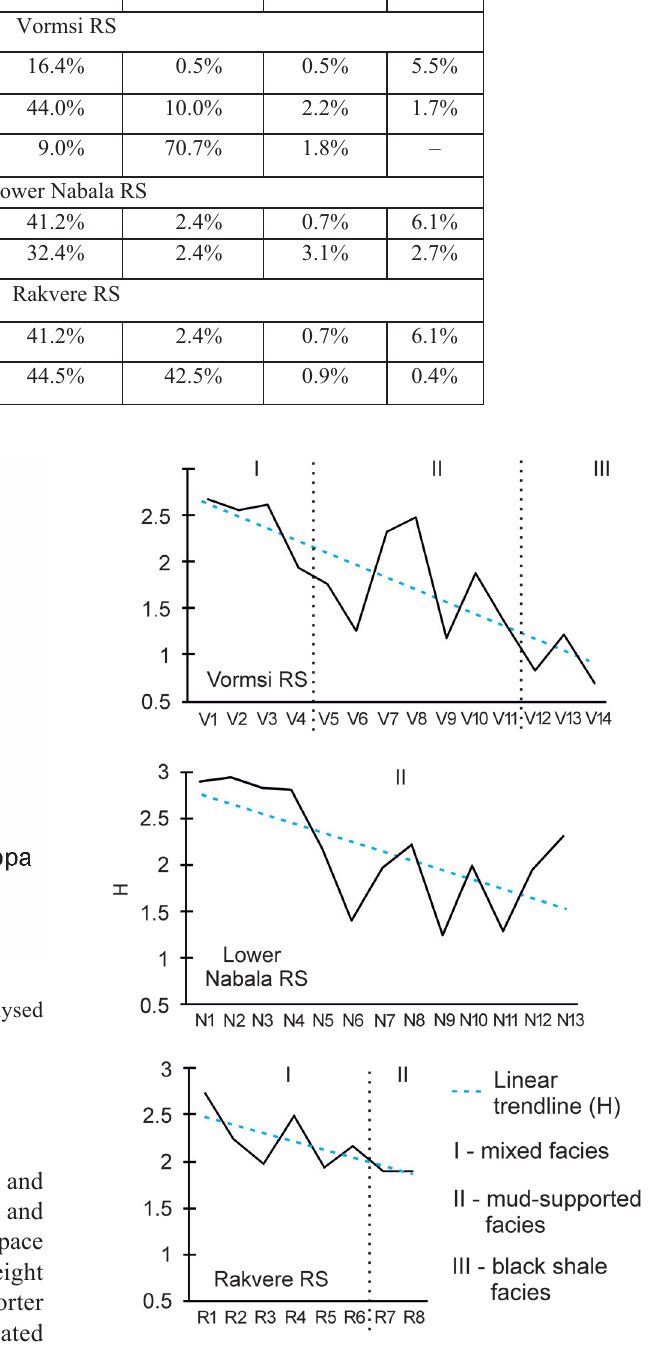
Fig. 10. Shannon index values showing the general trends of species diversity. H – Shannon index; I – mixed facies, II – mud- supported facies, III – black shale facies. Numbered section intervals are listed in the caption of Fig.